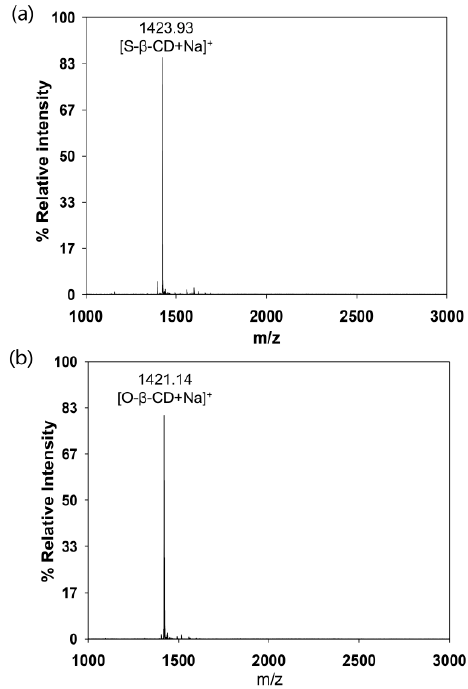
Figure 1. MALDI TOF mass spectra. ( a ) S- β -CD; and ( b ) O- β -CD.